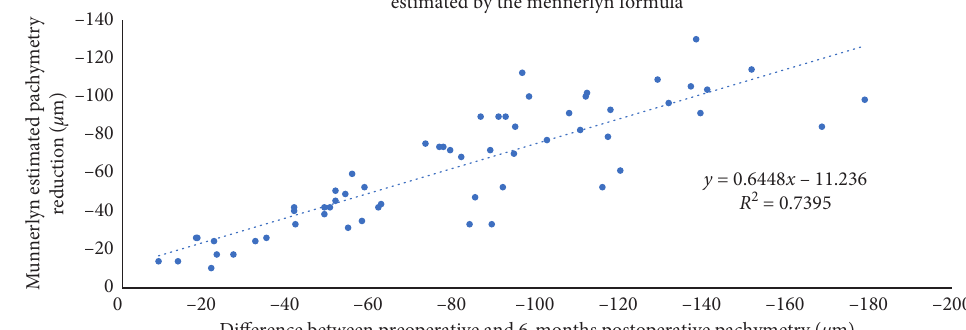
Figure 4: Positive correlation between the real reduction of the corneal thickness and the thickness estimated by the Munnerlyn